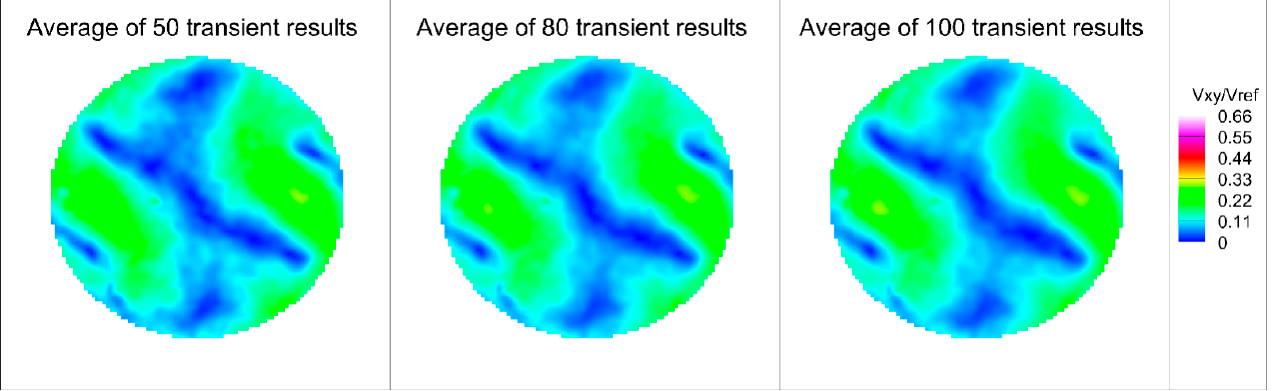
Figure 6. Comparison of different average choices.